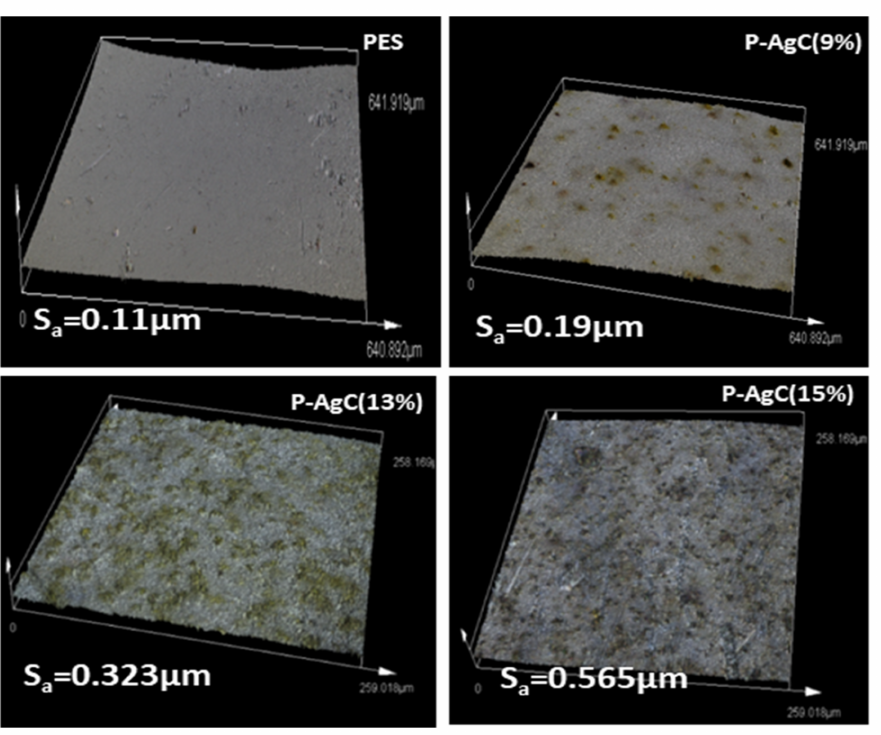
Figure 4. The surface roughness of the neat PES net, P-AgC (9%), P-AgC (13%), and P-AgC (15%) composite films.